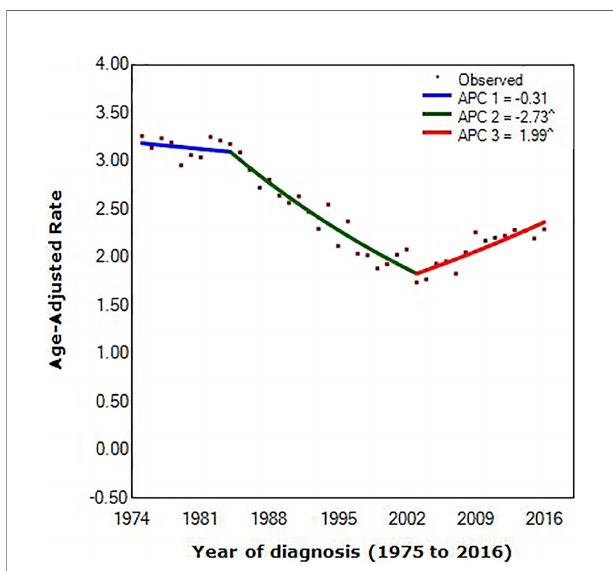
FIGURE 1 | Joinpoint regression of diagnosis of metaplastic breast cancer, by year. (^) p < 0.05; APC, annual percentage